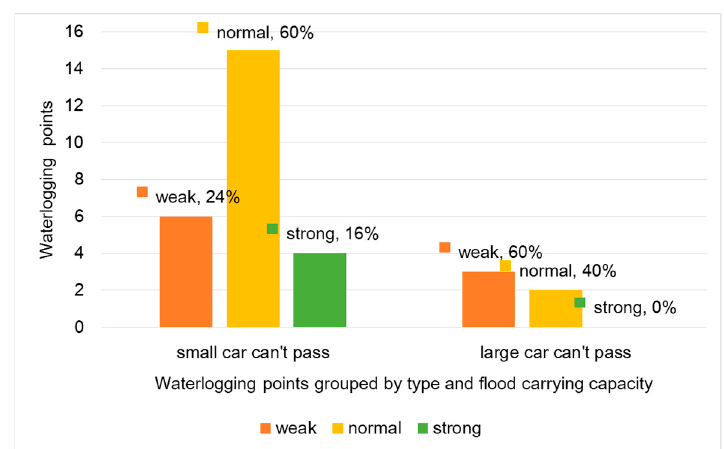
Figure 6. The ratio of waterlogging points grouped by “small cars cannot pass” and “large cars cannot pass” according to the location in the sub-catchment with “weak”, “normal”, and “strong”